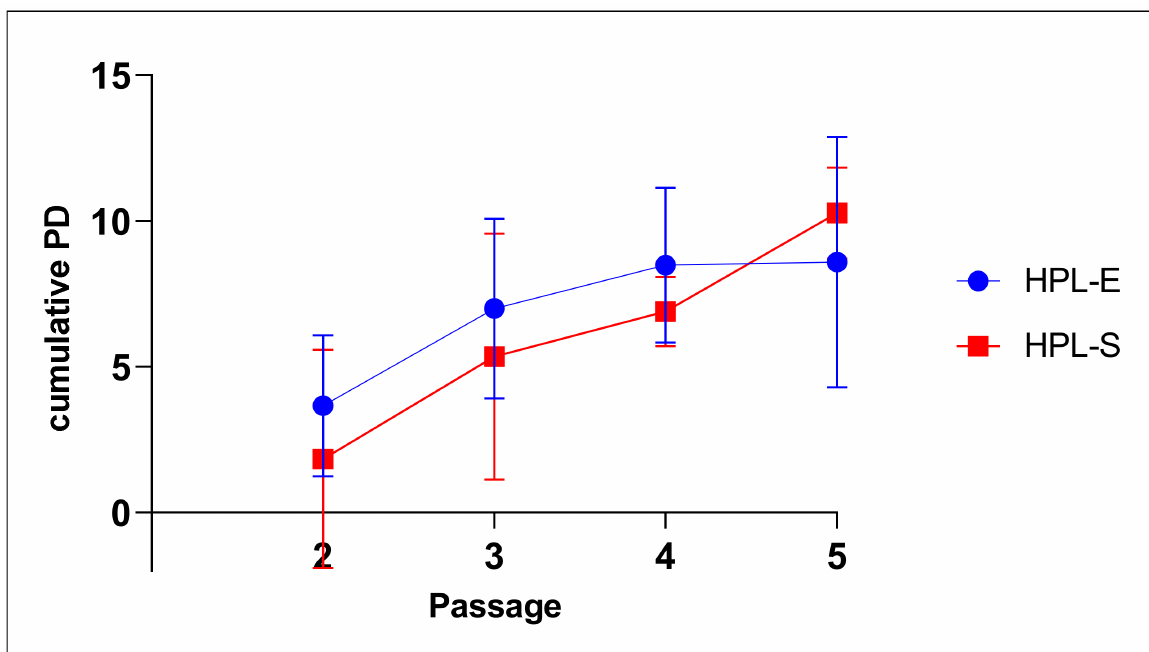
Figure 5. Cellular growth expressed as cumulative PD from 2nd to 5th passages during expansion on BM-MSC cultivated in HPL-E (blue curve) and HPL-S (red